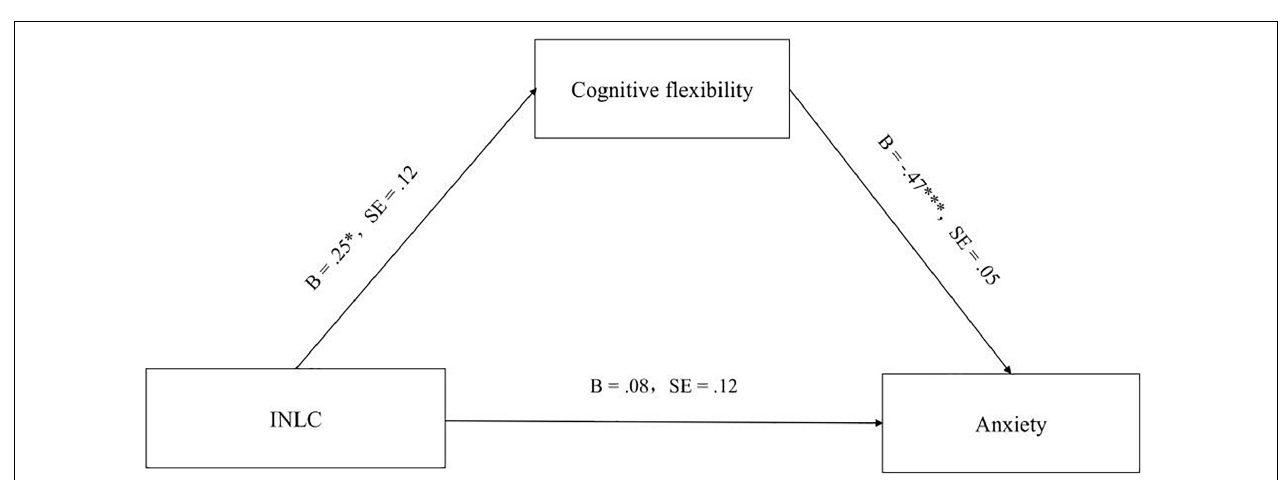
FIGURE 2 | The mediating of effect of cognitive flexibility on the link between CINL and